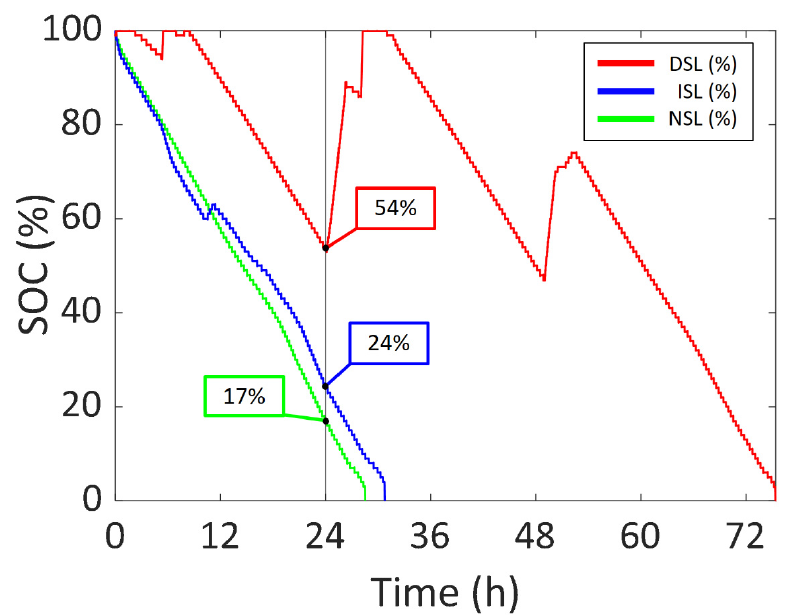
Figure 9. SOC vs. time of the first set of experiments.